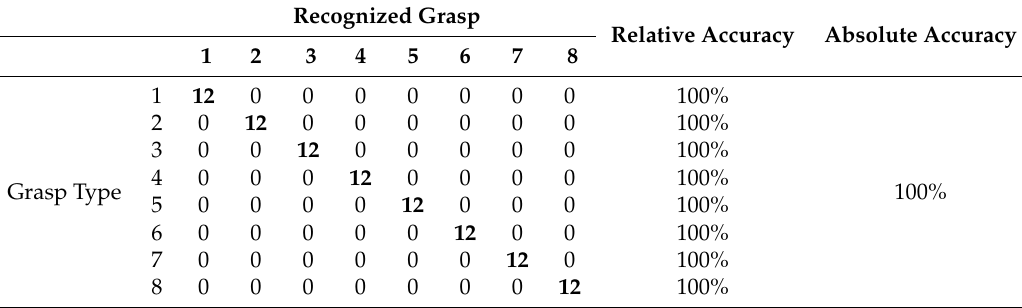
Table 2. Results: Volunteer 2.